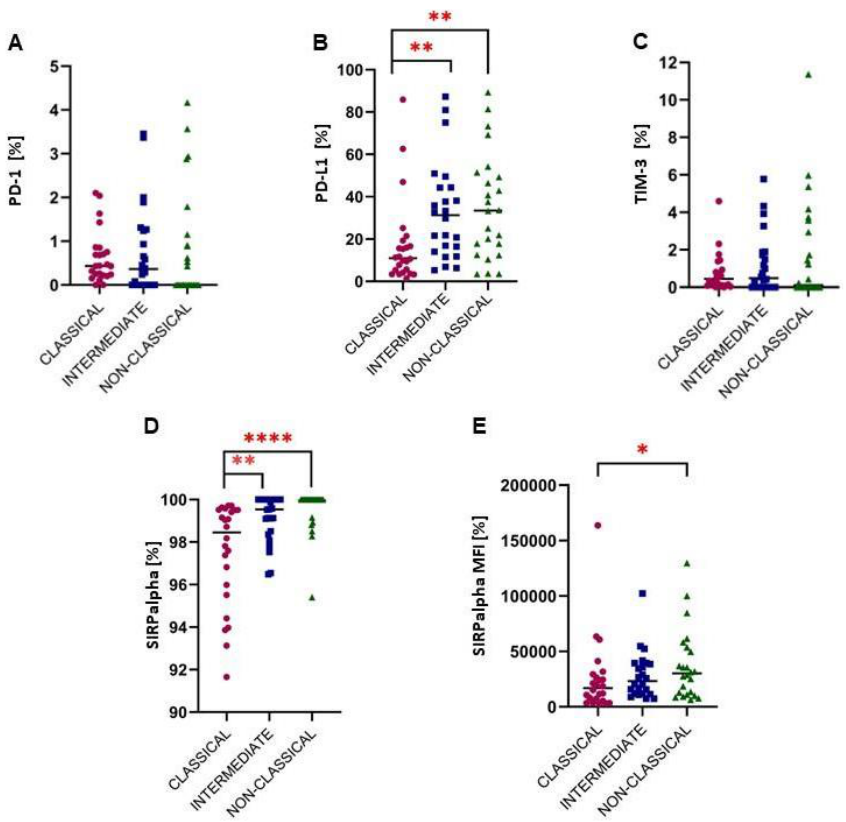
Figure 3. The identification of the differences in the immune checkpoint molecules: PD-1 ( A ) PD-L1 ( B ), TIM-3 ( C ) and SIRPalpha ( D,E ) expression between classical, intermediate and non-classical monocytes. Due to the expression exceeding 95% ( D ), for SIRPalpha the MFI assessment was used ( E ). * p < 0.05, ** p < 0.01, **** p < 0.0001 PD-1, programmed cell death 1 protein; PD-L1, programmed cell death 1 ligand; MFI, mean fluorescence intensity; SIRPalpha, signal-regulatory protein alpha.